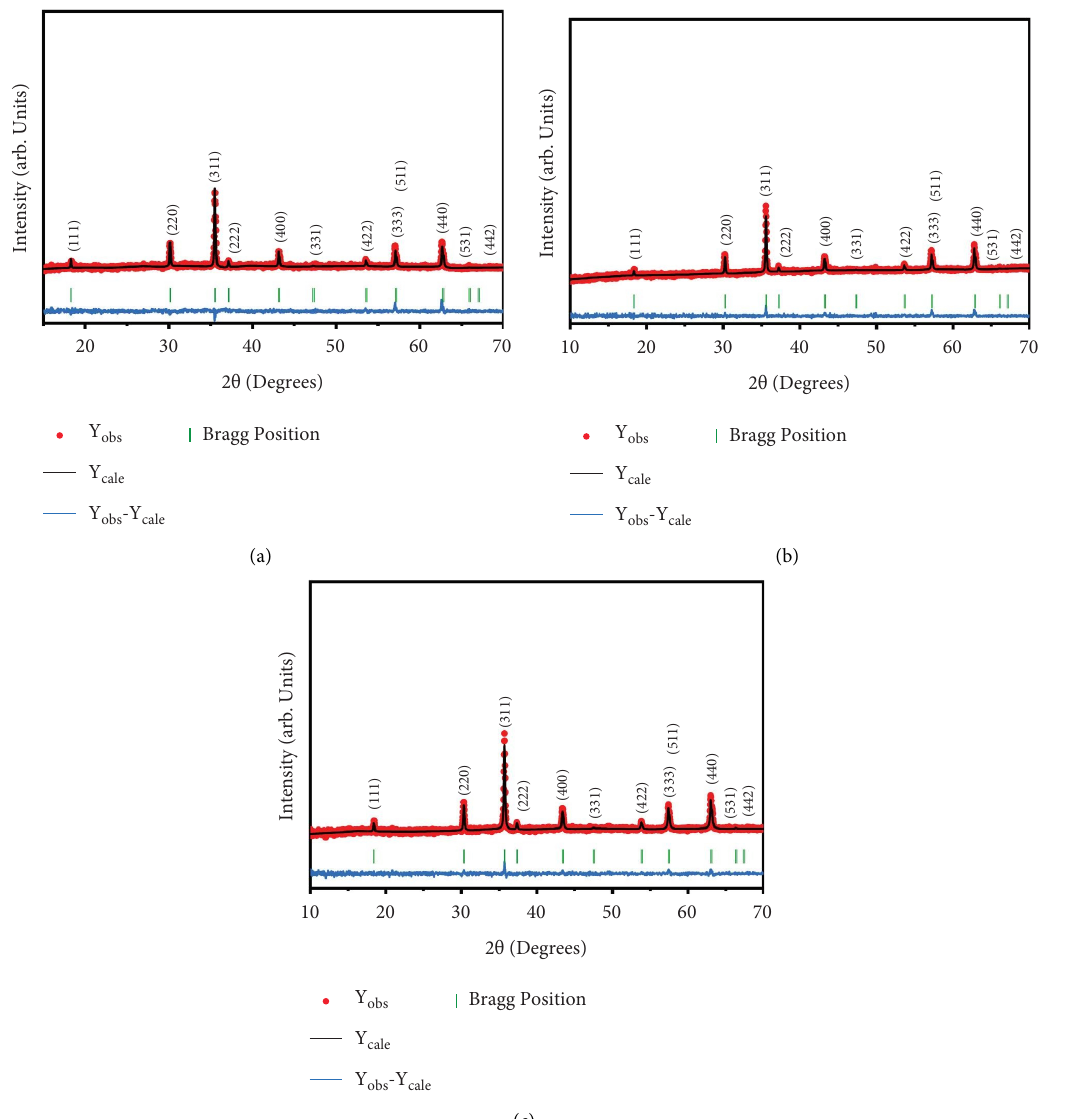
Figure 7: Rietveld refnement XRD plot for the typical (a) CoFe 2 O 4 , (b) Co 0.6 Ni 0.4 Fe 2 O 4 , and (c) NiFe 2 O 4 samples. Te measured data points ( Y obs .) are represented by red solid circles. Te black solid lines correspond to calculated patterns ( Y calc ). Te green vertical lines are the Bragg positions. Te diference between observed and calculated ( Y obs − Y calc ) plots is also shown as lines in blue color at the bottom of each pattern.